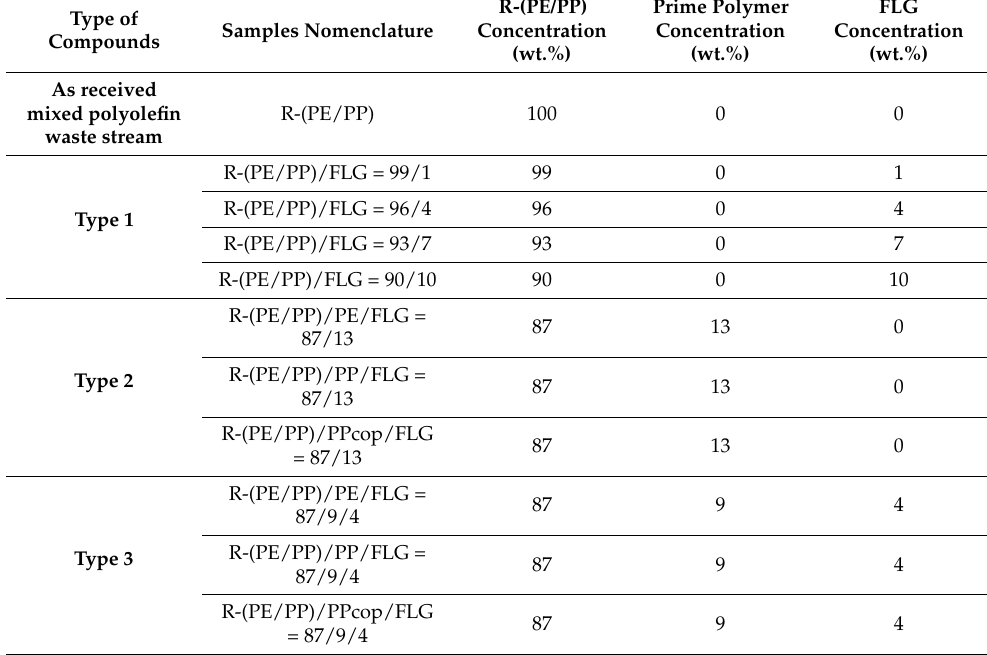
Table 2. Sample nomenclature and respective composition of the